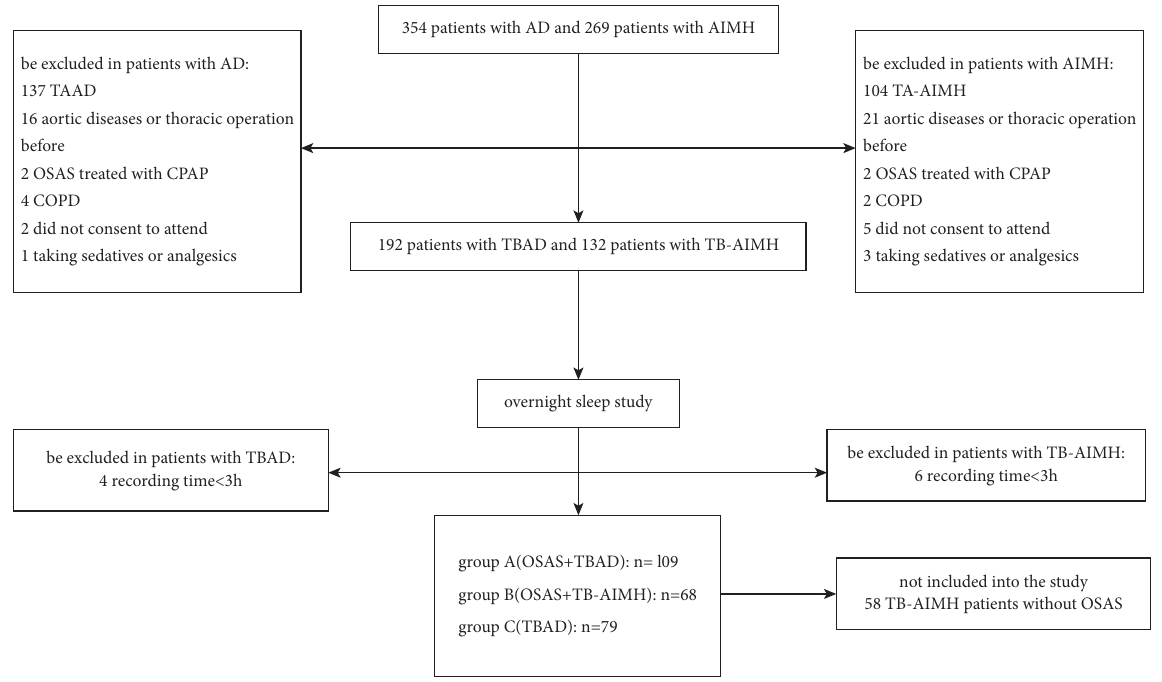
Figure 1: Study flowchart of patients’ selection process. Table 1: STOP-Bang